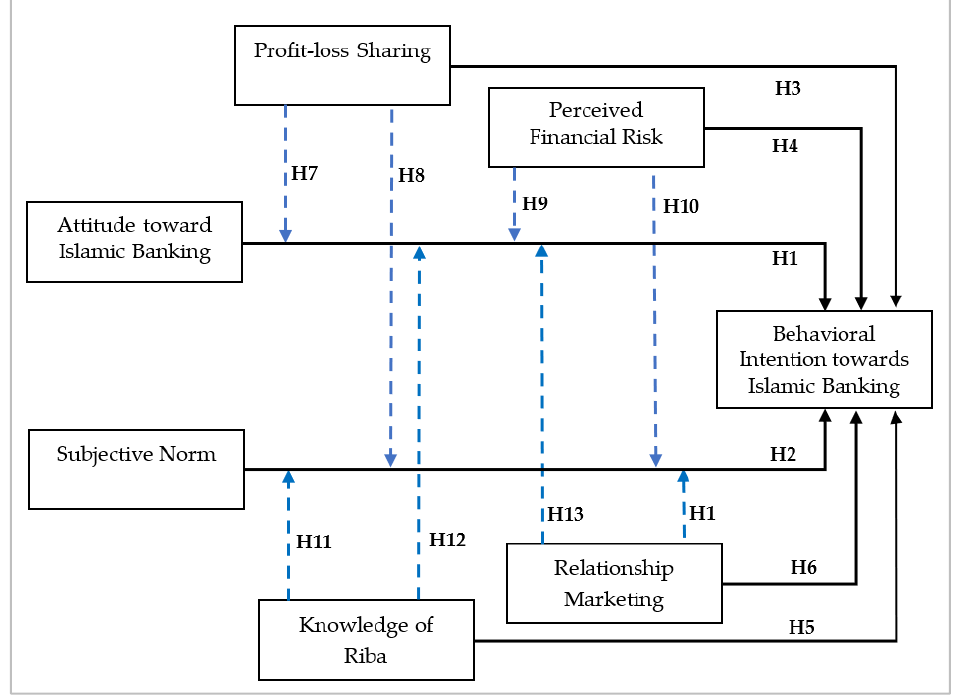
Figure 1. Research framework.